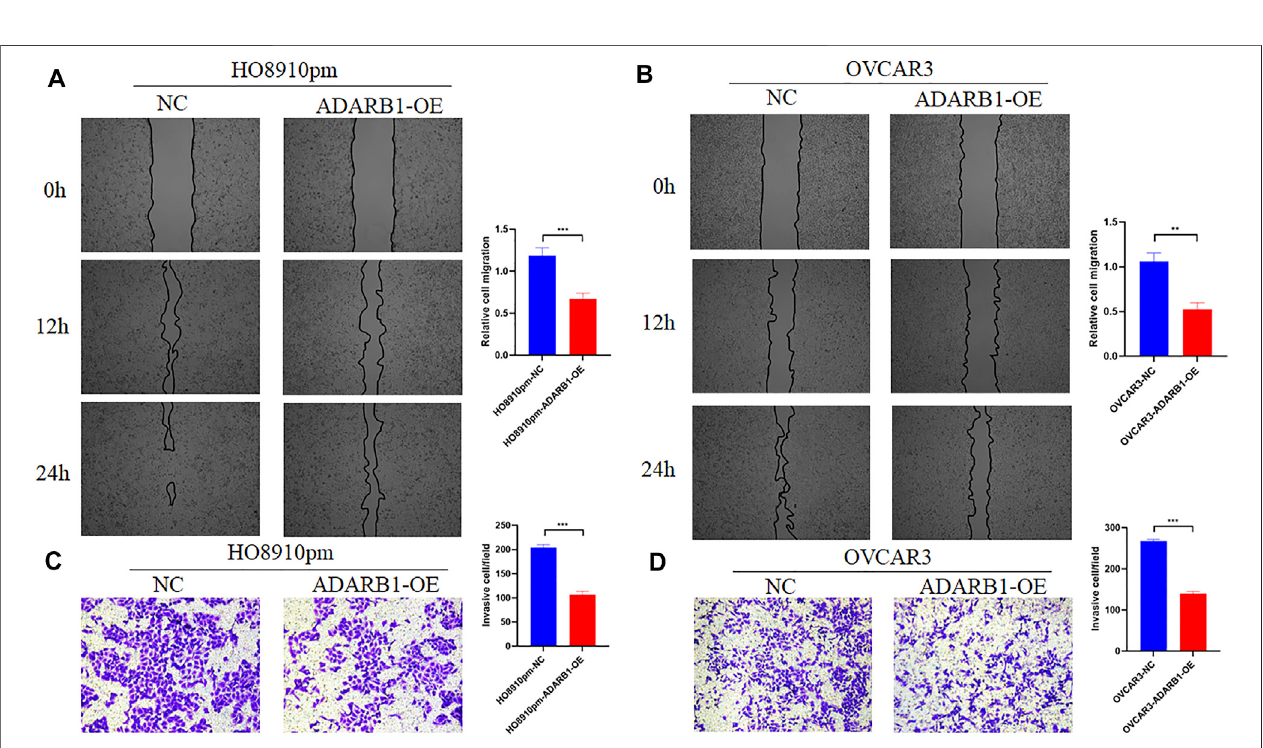
FIGURE 4 | Overexpession of ADARB1 inhibited the migration and invasion ability of OC cells. (A,B) The results of wound healing assay after transfected with ADARB1-OE in HO8910pm and OVCAR3 cells. (C,D) The results of transwell assay after transfected with ADARB1-OE in HO8910pm and OVCAR3 cells.